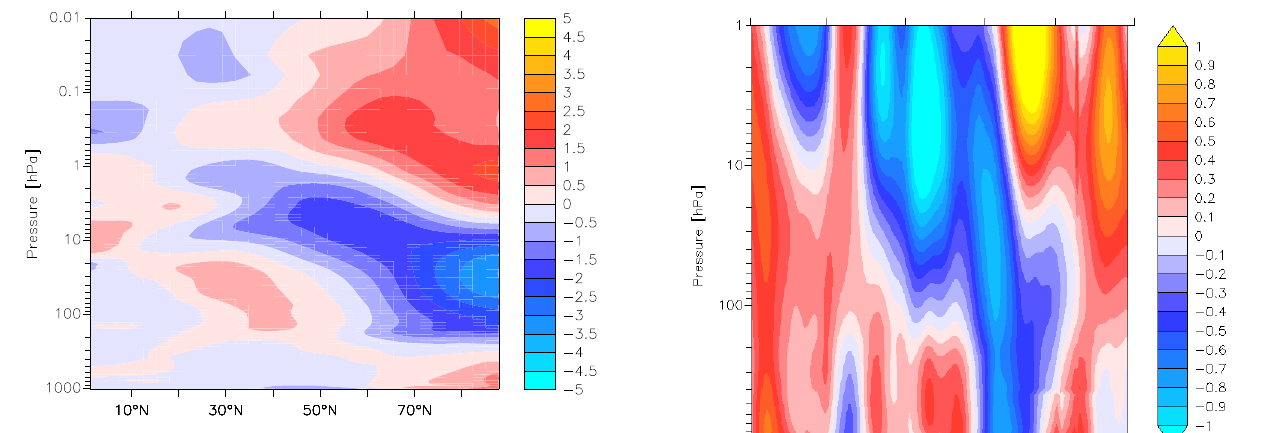
Fig. 9. Climatological DJF change of temperature (K), 1T = T S − EPP − T S − noEPP . Red-yellow/blue colours indicate posi- tive/negative differences.